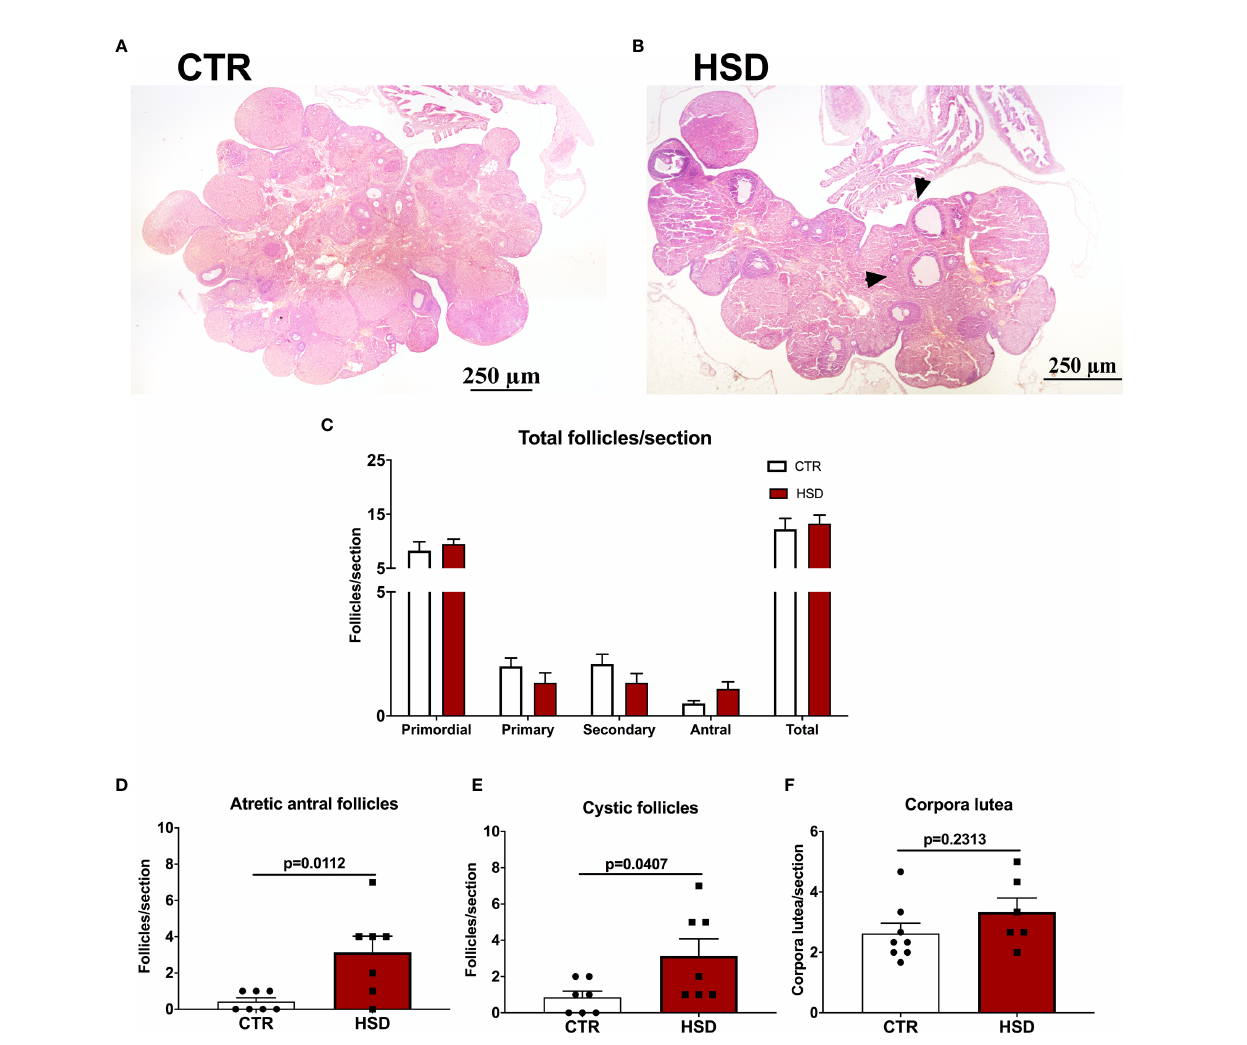
FIGURE 4 | High-sucrose diet (HSD) ingestion causes ovarian dysfunction in female rats. Ovaries were analysed and follicles classi fi ed according to Materials and Methods . (A) Representative micrograph of an ovary from a CTR rat. (B) Representative micrograph of an ovary from an HSD rat, depicting cystic follicles (arrowheads). (C) Number of primordial, primary, secondary, antral and sum of all follicles (total) per section. (D) Number of atretic antral follicles per section. (E) Number of cystic follicles per section. n=7-8 animals in each group. (F) Number of corpora lutea per section. Graphs express mean ± SEM and bar graphs show individual values. P-values are shown in bar graphs when signi fi cant (p < 0.05) and were calculated using two-way ANOVA in (C) and unpaired Student t-test in (D – F)